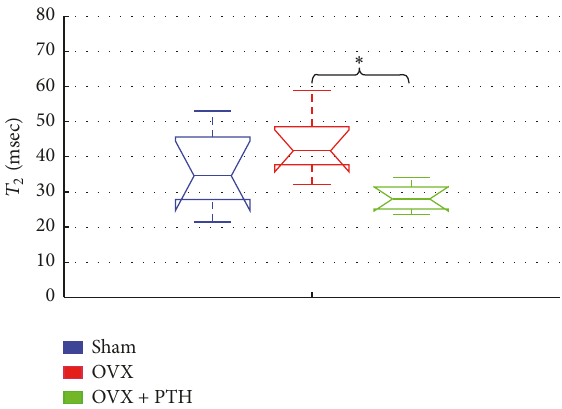
Figure 10: Therapeutic treatment experiment: ADC measurements of Sham, OVX, and OVX + PTH tibiae bones, measured 11 weeks after operation. Significant decrease for the tibiae OVX bones compared to the Sham tibiae bones when measured in the central zone (by Kruskal-Wallis test followed by Bonferroni multiple- comparison test ∗ 𝑃 < 0.006